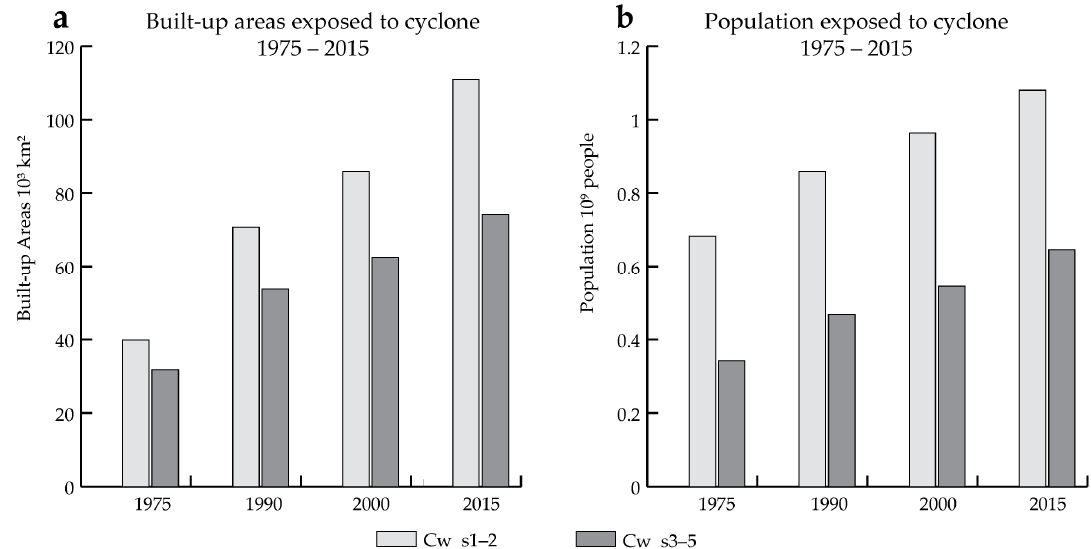
Figure 6. Built-up area ( a ) and population ( b ) in regions in which the cyclone winds may reach category 1 and 2 (Cw_1-2), and exceed category 3 (Cw_3-5) based on a probabilistic hazard assessment with return period of 250